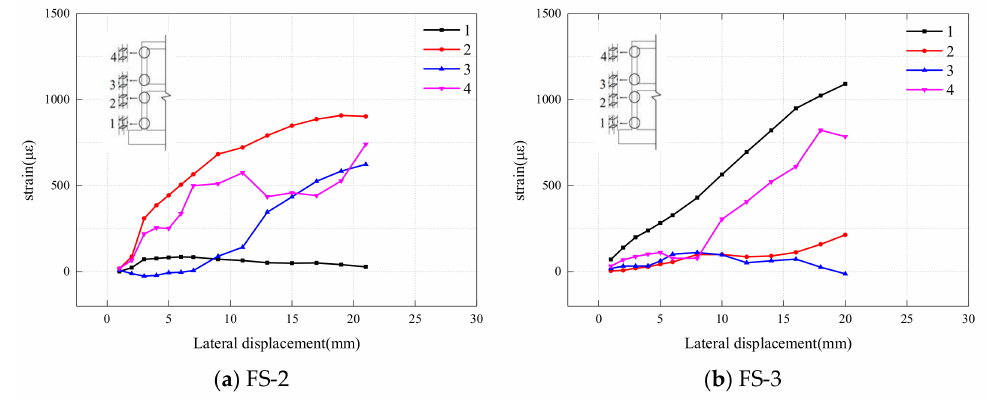
Figure 15. Strain of column